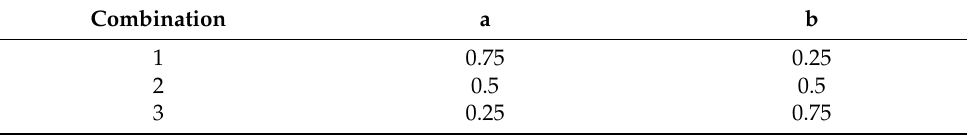
Table 6. Analysed combinations of weight values.